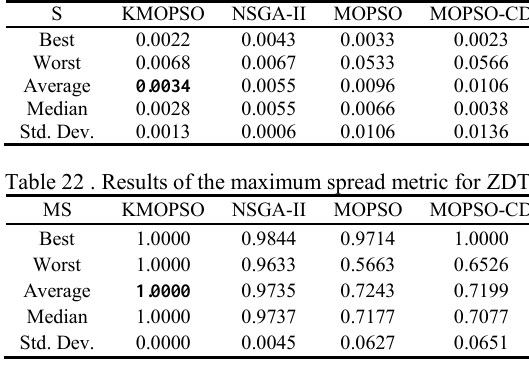
Table 21 . Results of the spacing metric for ZDT6.